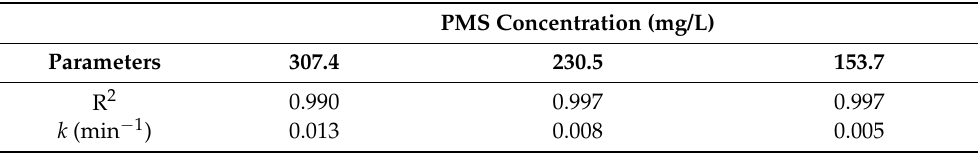
Figure 4. Antipyrine’s degradation profiles for three different concentrations of PMS (circle: 153.7 mg/L, triangle: 230.5 mg/L, and square: 307.4 mg/L). All experiments were made with the same concentration of Basolite ® F-300 (65.8 mg/L) and antipyrine (10 mg/L). The figure inside represents the kinetic model fittings at each PMS concentration. Data represent the mean values for triplicate samples with a standard deviation below 5%. Table 5. First-order kinetic of antipyrine degradation; its concentration is 10 mg/L in the presence of Basolite ® F-300 (65.8 mg/L) and a certain concentration of PMS (153.7–307.4